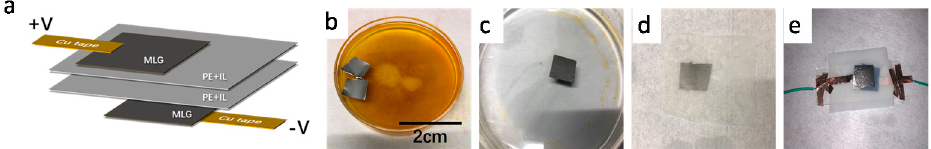
Figure 1. Device fabrication. ( a ) Schematic of the infrared multilayer graphene devices. ( b ) The optical image of the etching process. ( c ) The optical image of the deionized water washing process. ( d ) The optical image of multilayer graphene on a porous polyethylene membrane. ( e ) The optical image of the final device.